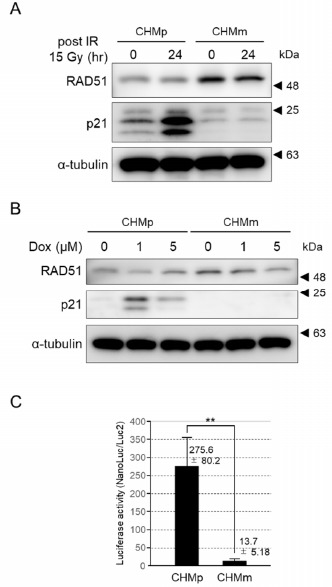
Figure 7. Induction of p21 expression in response to DNA damage, and measurement of transcrip- tional activity of p21. Expression levels of RAD51 and p21 in CHMp and CHMm after 24 h with 15 Gy irradiation ( A ) and 1 or 5 μ M doxorubicin exposure ( B ). α -tubulin was used as a loading control. ( C ) The luciferase activities reflect the p21 transcriptional ability of endogenous CHMp and CHMm cells. The results are given as the mean ± SD. Asterisks on top of the brackets indicate significant differences calculated using ANOVA with Tukey’s multiple-comparison test (** p <